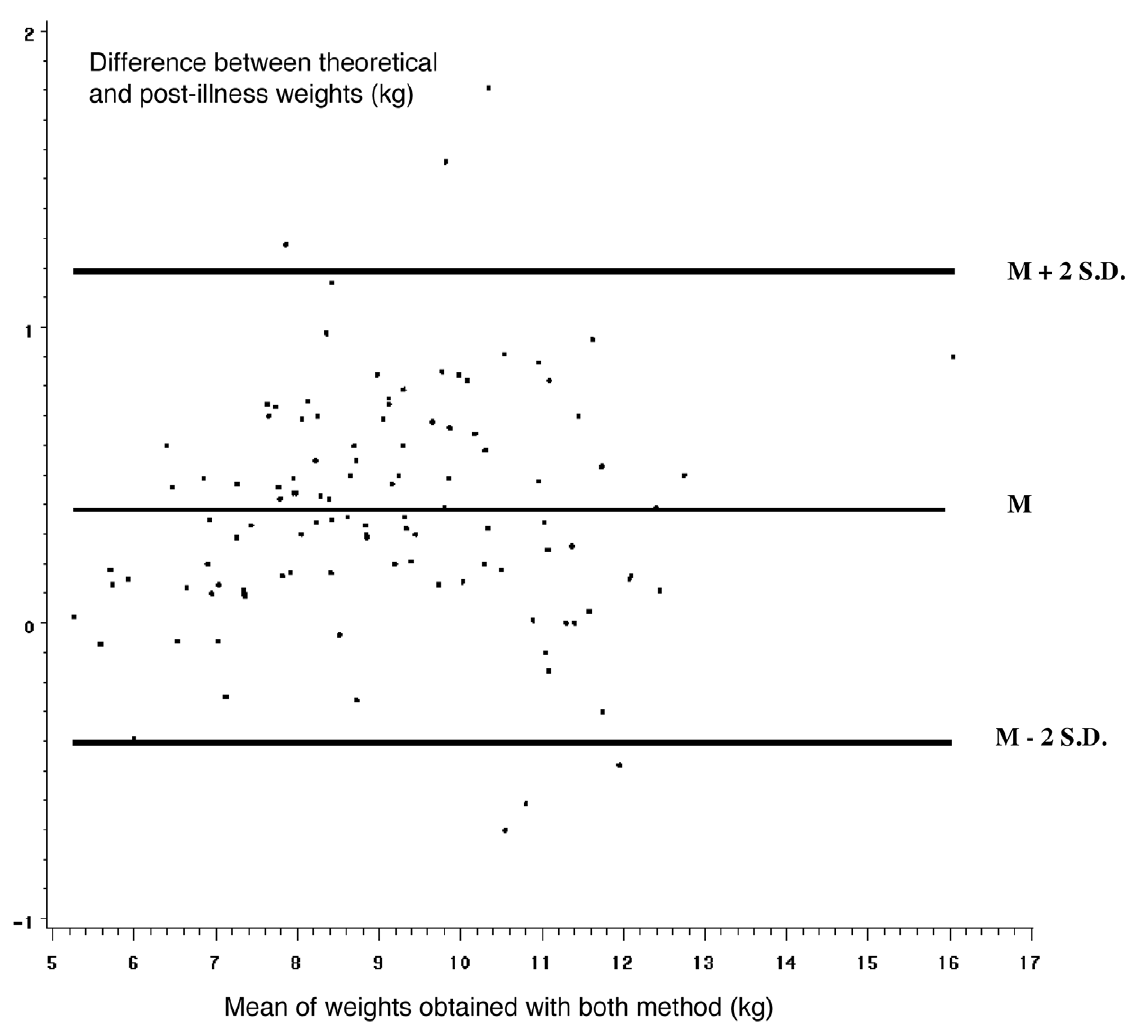
Figure 3. Agreement between theoretical and post-illness weight, analysed with a Bland-Altman plot, n=111. M: mean, SD: Standard Deviation. Mean difference, which is the best guess as to the ‘‘correct’’ result. 95% limits of agreement. When the agreement between two measures is high, the mean difference between these two measures is close to 0. The 95% limits of agreement permit visual judgement of how well two methods of measurement agree. The smaller the range between these two limits the better the agreement is.